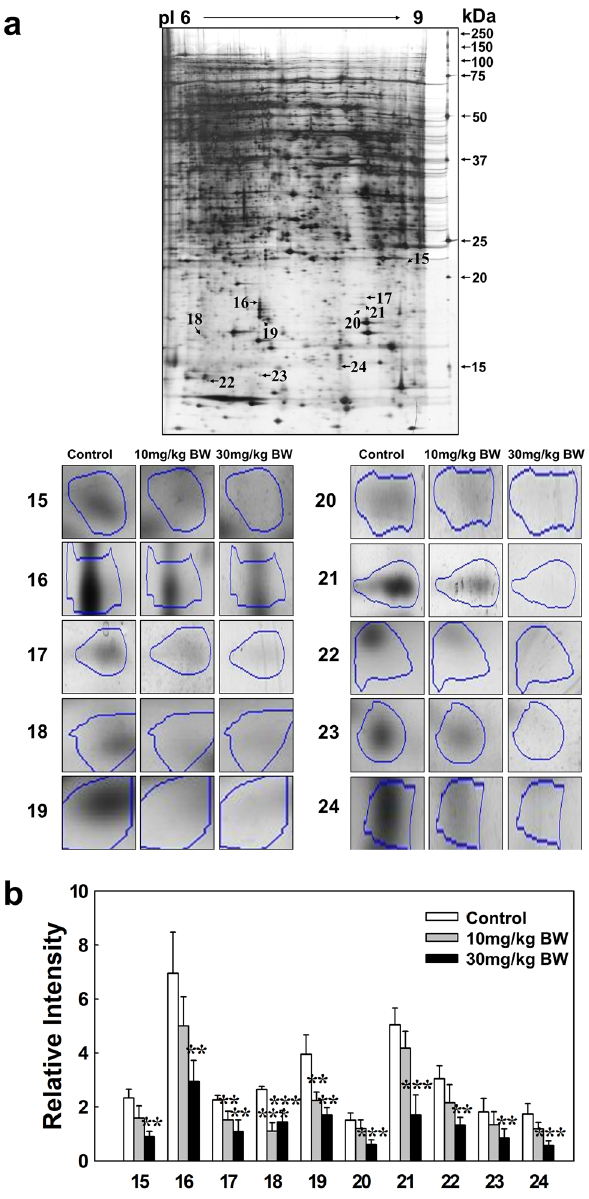
Figure 5. 2-DE analysis of kidney tissue proteins obtained using 6–9 pI range strips. ( a ) Gel pattern of tissue proteins obtained using 6–9 pI strips. Protein spot images were analyzed using the Progenesis Samespot software program (Nonlinear Dynamics, Newcastle upon Tyne, UK). ( b ) Spot volumes were normalized by comparison to the total spot volume. The quantity of each spot is presented as the relative intensity. The images represent the mean ± SD of five separate experiments. ** and *** indicate p -values of 0.01 and 0.001, respectively, compared to the